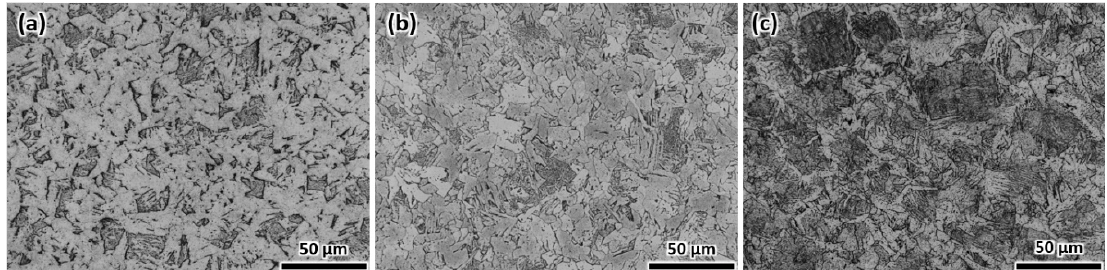
Figure 1. The optical microstructures obtained from the samples deformed to a strain of 0.7 at a strain rate of 1 s − 1 and deformation temperatures of ( a ) 900 °C; ( b ) 930 °C and ( c ) 960 °C. The samples were water quenched immediately after deformation.